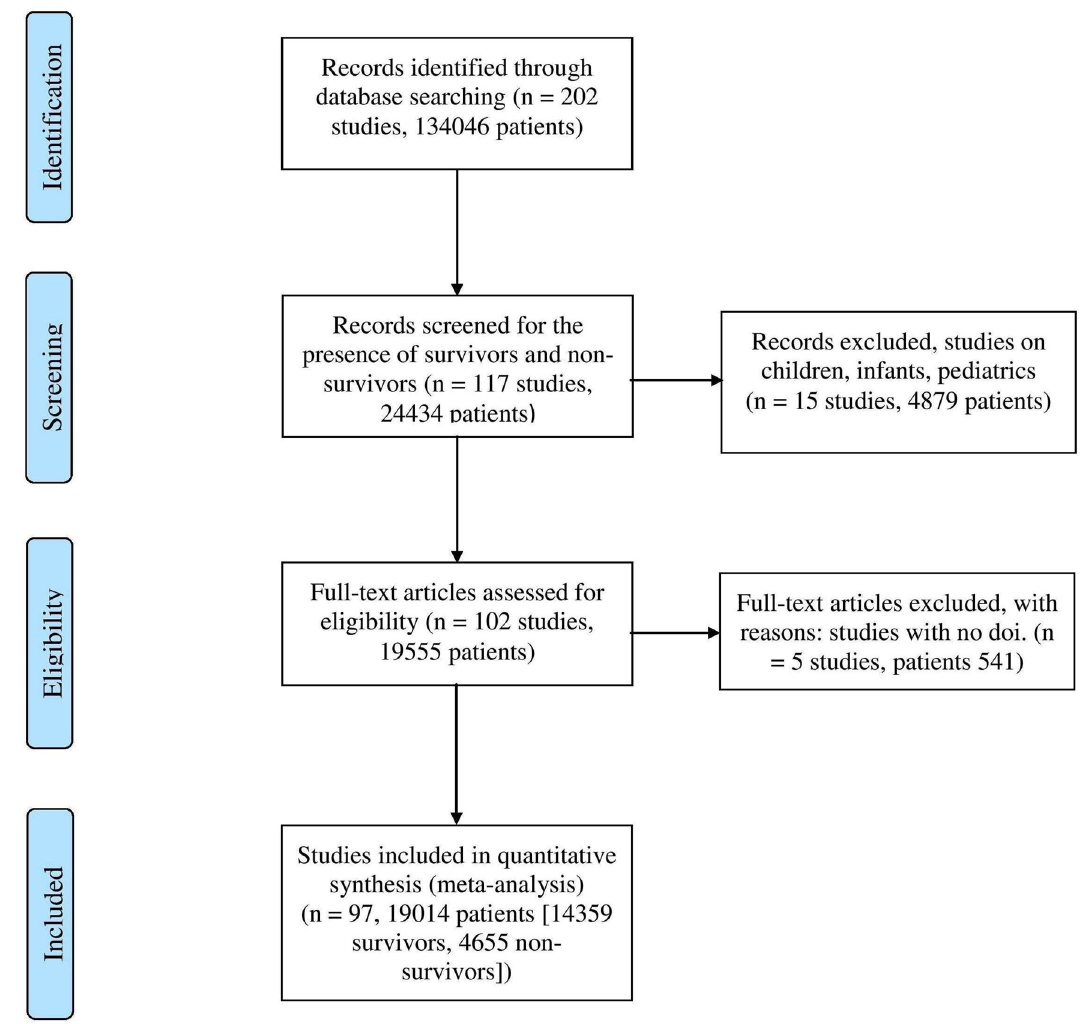
Figure 1. PRISMA flow diagram of the studies identified, screened, reviewed, and included in the meta-